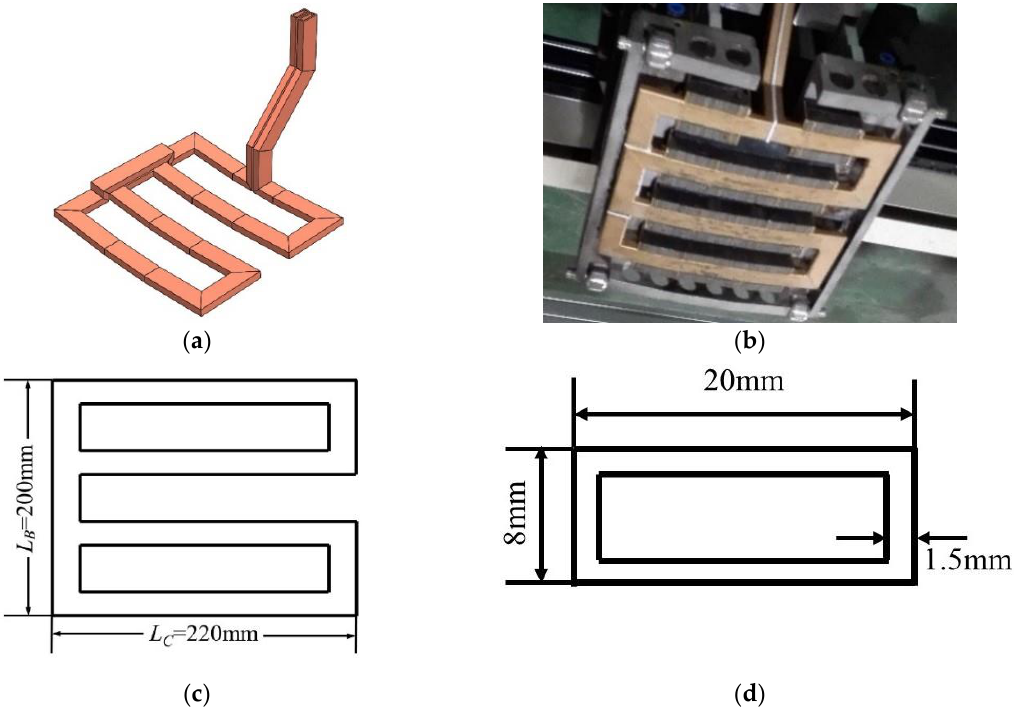
Figure 2. Shape and dimension of the induction coil: ( a ) coil model; ( b ) coil image; ( c ) coil dimension and ( d ) tubular dimension of the coil.